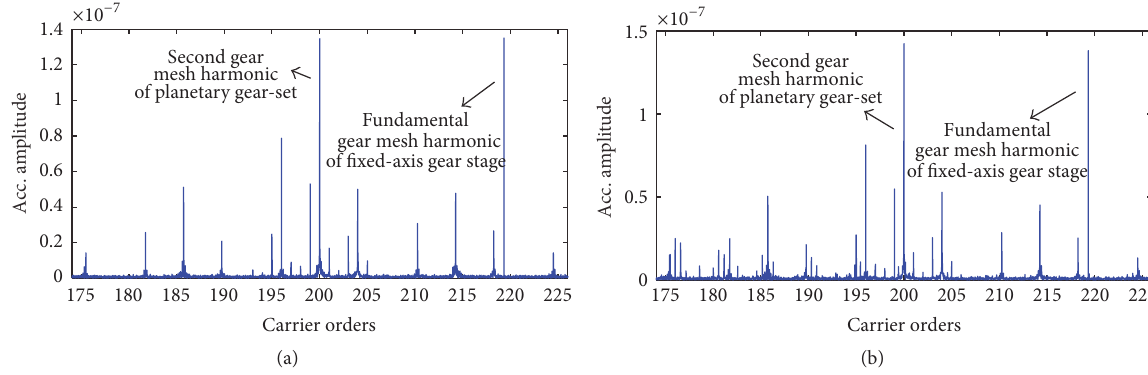
Figure 9: (a) The simulated raw vibration spectrum under the healthy case; (b) the simulated raw vibration spectrum under the severe sun gear faulted case.